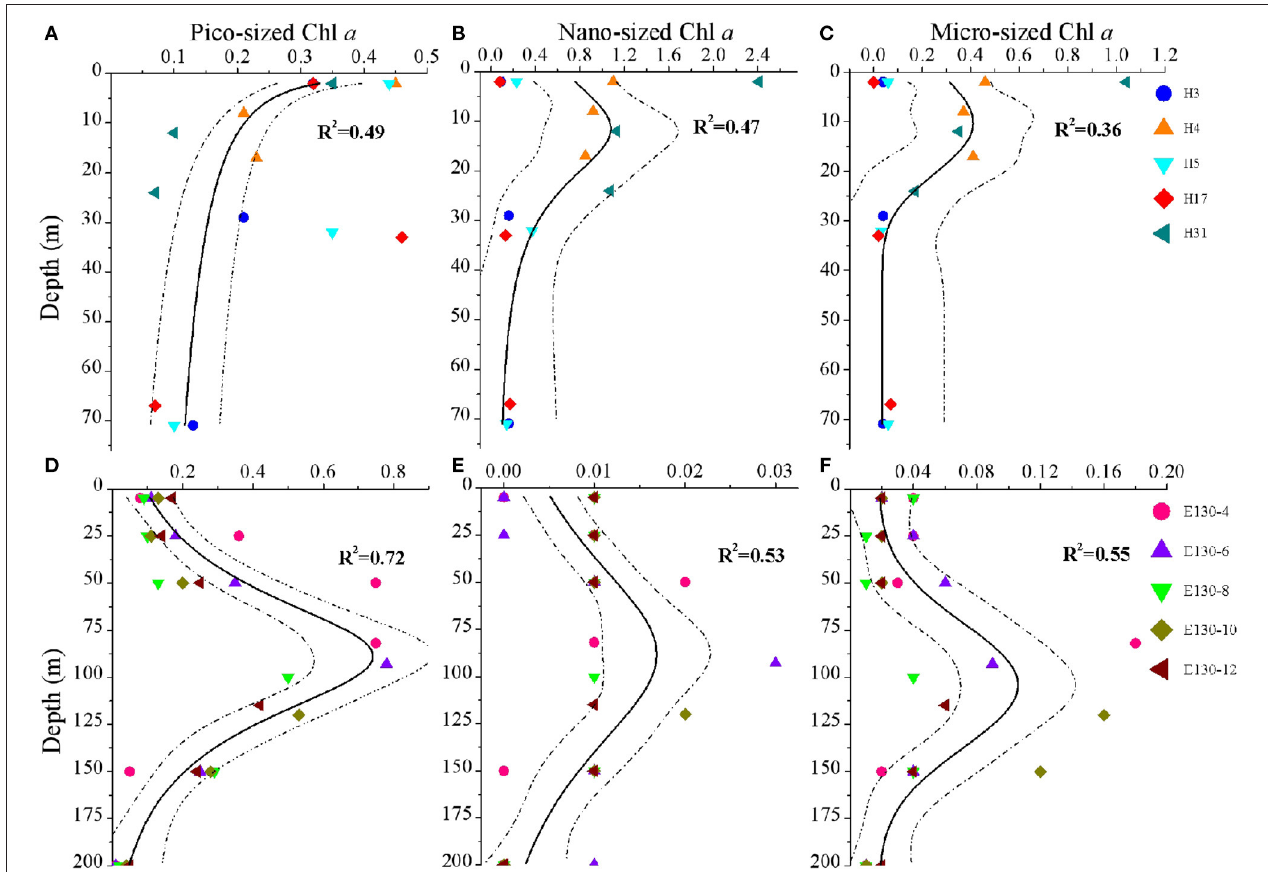
FIGURE 3 | Vertical profiles for the concentrations ( µ g L − 1 ) of (A,D) pico-sized Chl a , (B,E) nano-sized Chl a , and (C,F) micro-sized Chl a in the Yellow Sea (above) and the Western Pacific (below). Symbols and colors represent sampling stations. Solid lines indicate different curve-fitting trends for the size-fractionated Chl a data vs. depth, and dashed lines denote 95% confidence bands. R 2 is the fitting variance of the non-linear regression model. Note the different scales on the x -axes, reflecting variability in the magnitude of the size-fractionated Chl a concentrations.